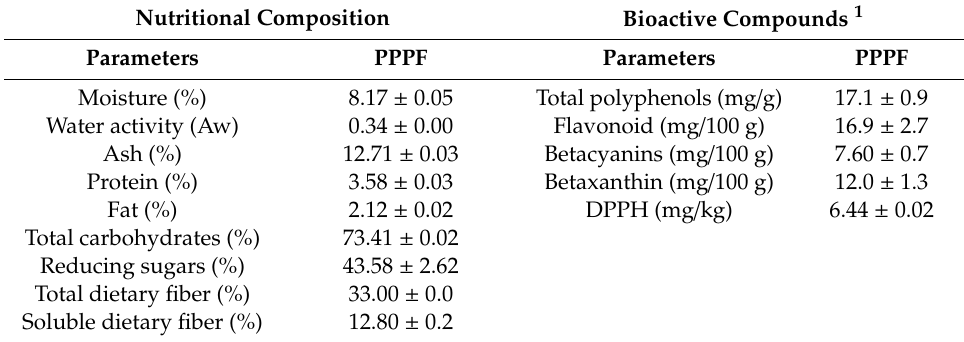
Table 2. Nutritional and functional characterization of prickly pear peel flour (PPPF). Nutritional Composition Bioactive Compounds 1 Parameters